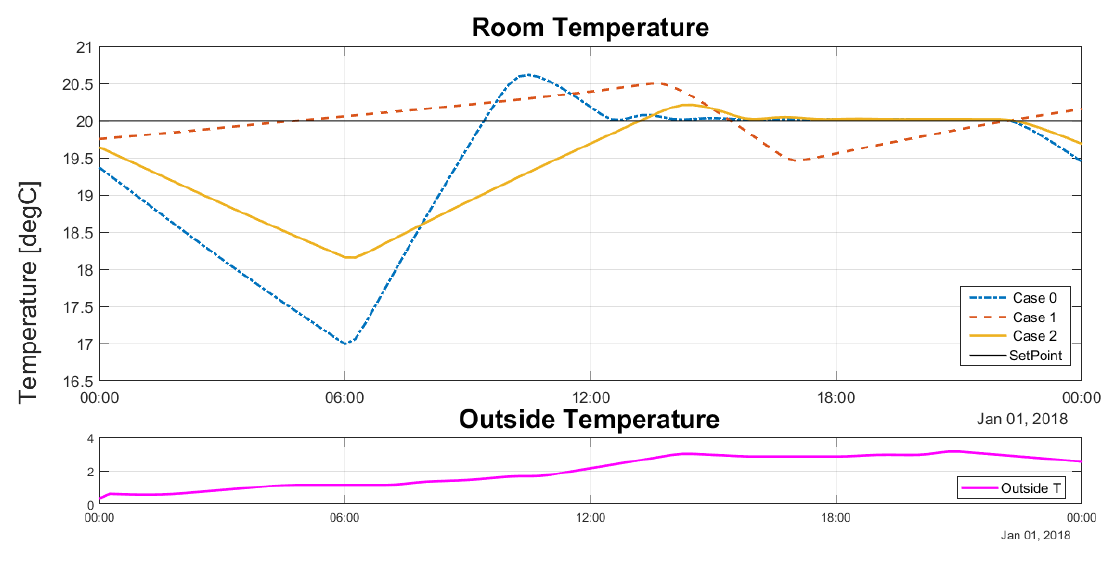
Figure 6. Comparison of temperature profiles (1 January).